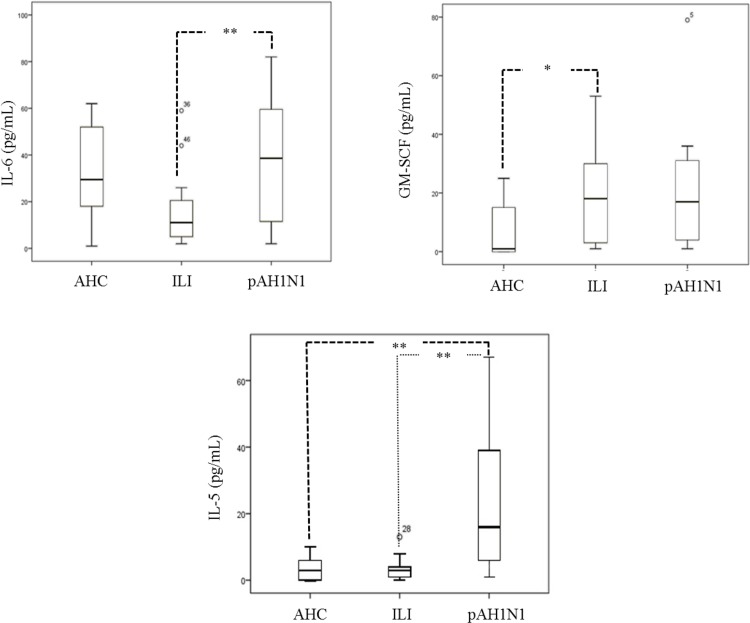
Concentrations of IL-6, IL-5, and GM-SCF in p AH1N1, ILI patients and AHC at admission.Box and whisker plots of cytokine levels in sera from the AHC, ILI, and pA/H1N1 groups. Boxes represents the 25–75 quartile, the whiskers represent the range of values, the middle line inside the box is the median, and the outlier values are represented as circles outside the boxes. The p-values (** and * representing <0.001 and <0.05, respectively) were calculated by one-way ANOVA and are presented above the graphs.